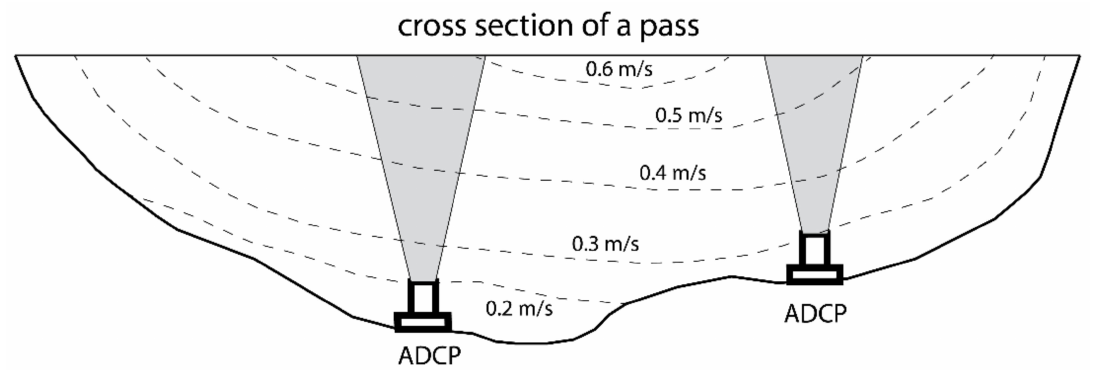
Figure 1. Using bottom-mounted ADCP(s) to measure flow profiles and estimate cross-sectional transport. Contour lines are hypothetical flow velocity magnitudes across the section (flow is into or out of the